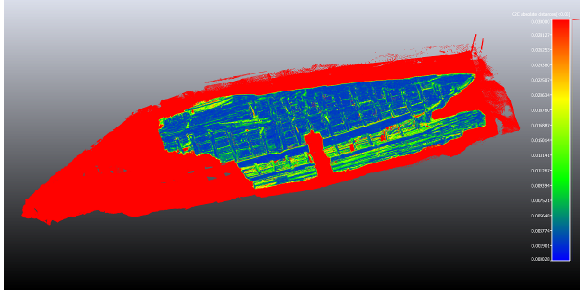
Figure 10. Comparison between point clouds 2014 and 2015 by laser scanning survey.